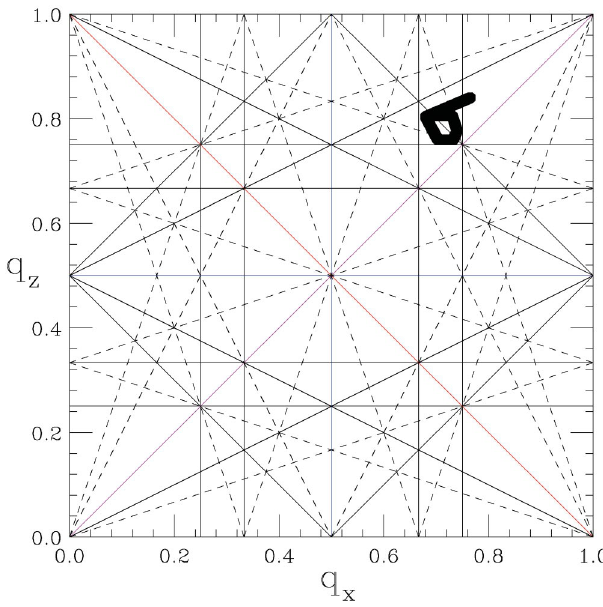
FIG. 27. (Color) The fractional part of the betatron tune during the entire ramping cycle from injection at 400 MeV to the top energy at 8. GeV (see Fig. 9 in